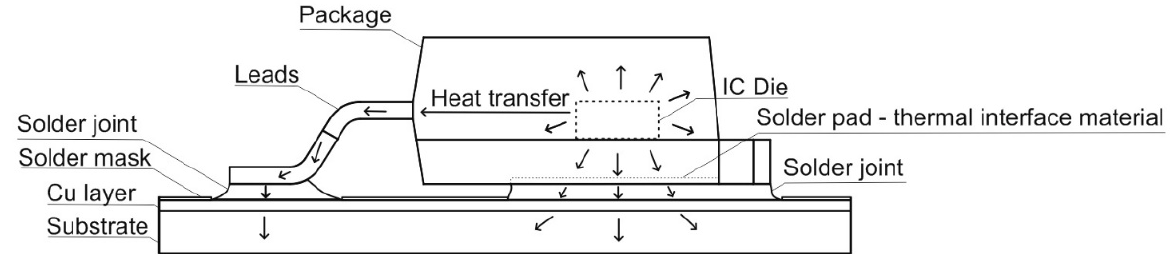
Figure 1. A simplified diagram of the heat flow through the component to the FR4 substrate. The arrows show an example of the direction of heat dissipation.